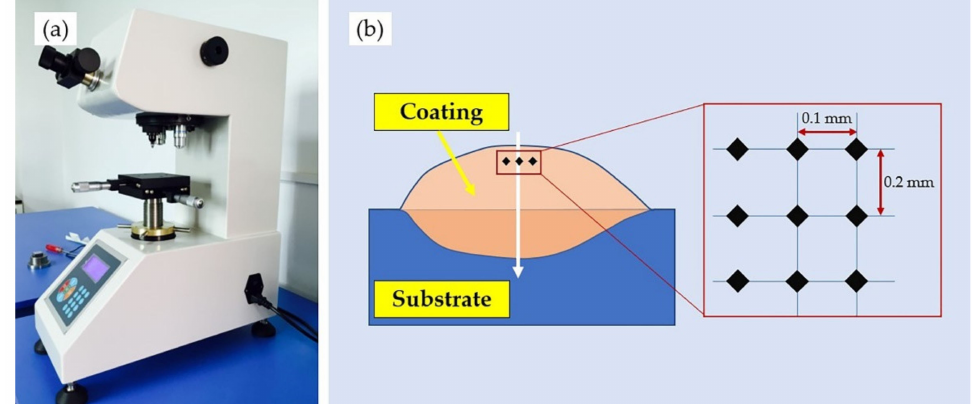
Figure 3. Microhardness tester: ( a ) Overview of the equipment; ( b ) Measurement path.